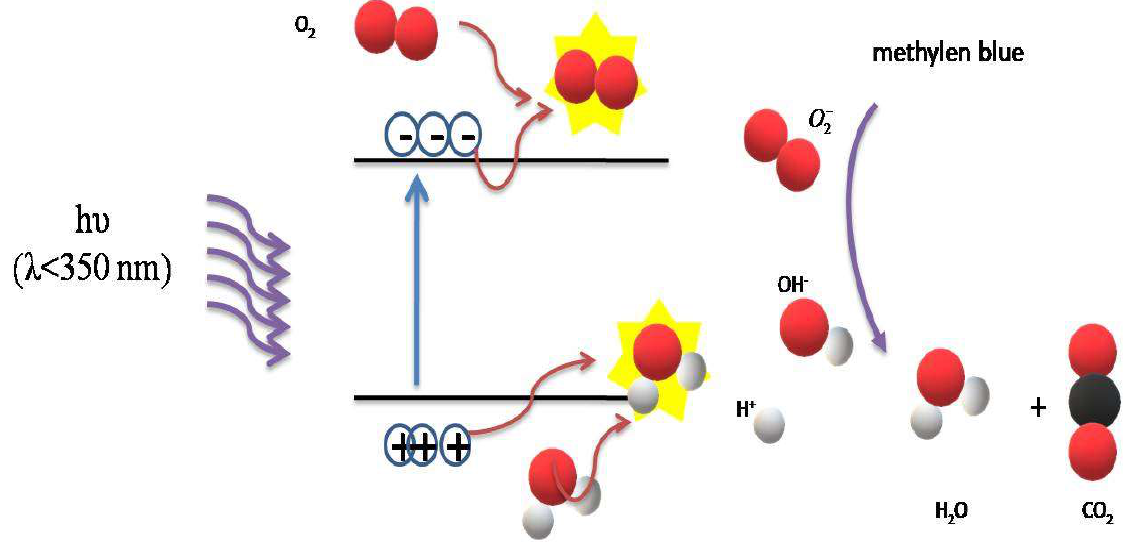
Figure 7. Schematic photodegradation diagram.